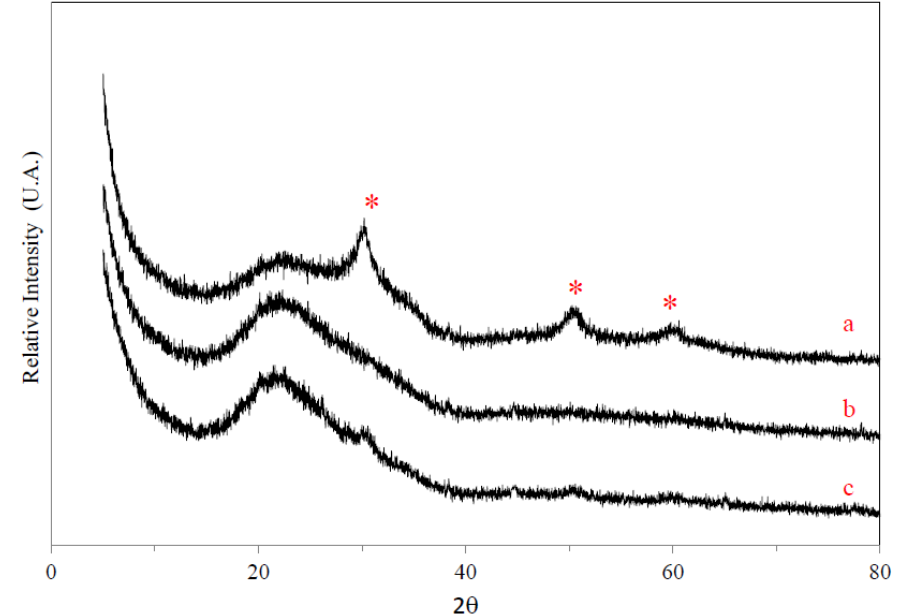
Figure 2. XRD patterns of VOx/yZrOx/S: ( a ) VOx/20ZrOx/S, ( b ) VOx/10ZrOx/S, and ( c ) VOx/5ZrOx/S. (*) ZrO 2 .